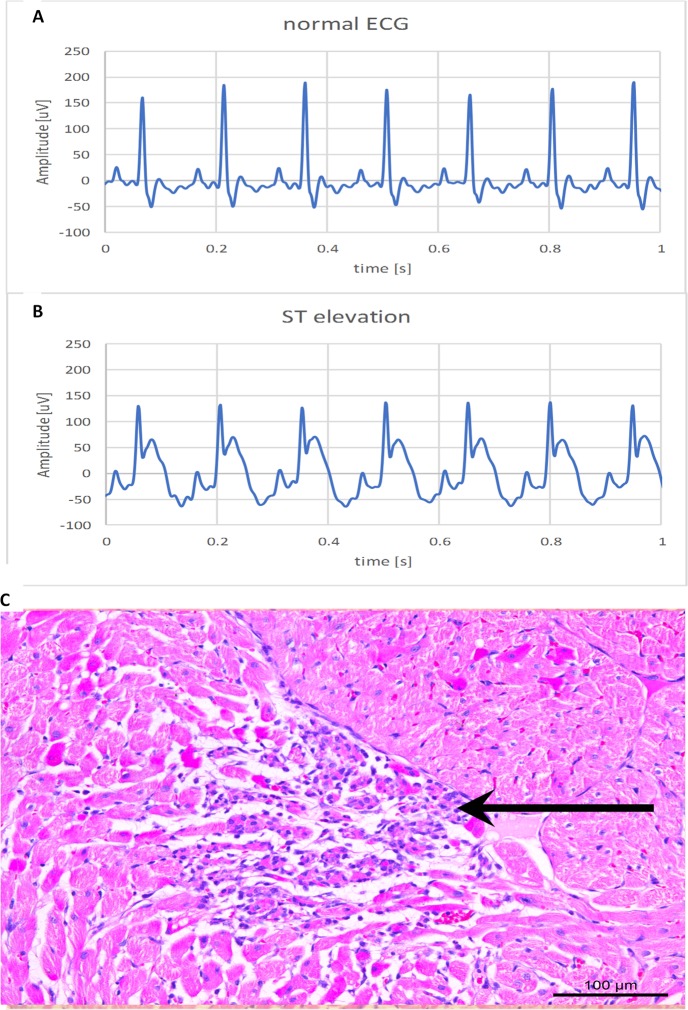
ECG and histological changes after isoprenaline administration.(A) Normal ECG trace, (B) ECG containing ST elevation, (C) Histological changes in the myocardial wall 24 hours after i.p. application of isoprenaline. In the central part of the picture we can notice necrotic cells with hyper-eosinophilia, pyknotic nuclei, and inflammatory cell infiltration (arrow). The ischemic area is surrounded by viable myocardial cells.